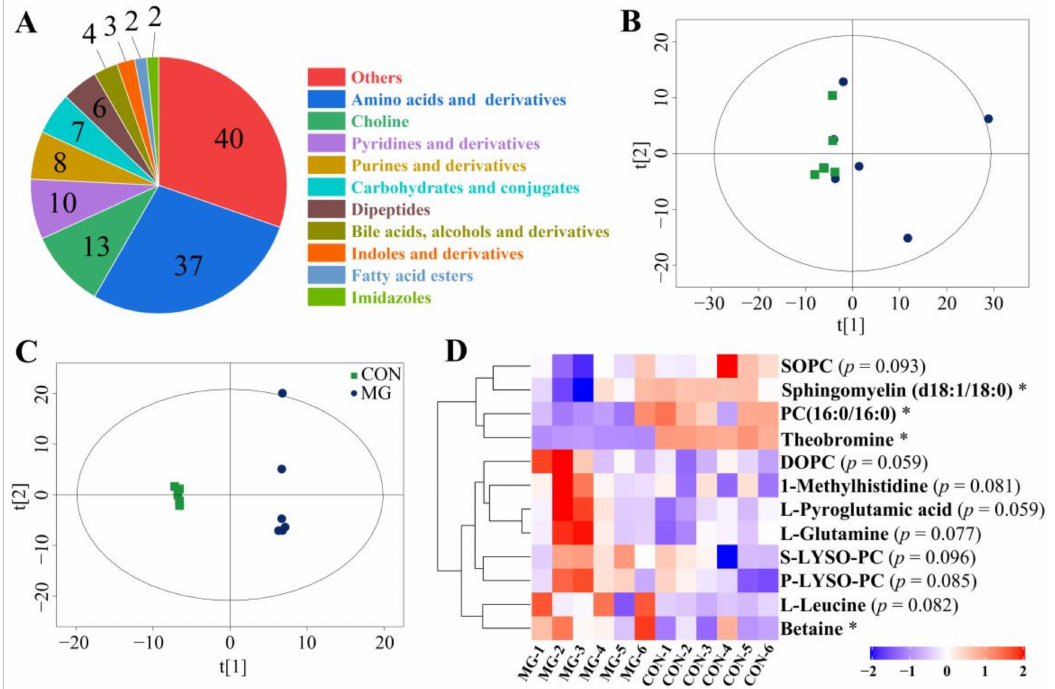
Figure 1. Serum metabolite differences with MG supplementation. ( A ) Pie chart of serum metabolites. Principal component analysis (PCA) score plot ( B ) and OPLS-DA score plot ( C ). ( D ) Heatmap of significant differential metabolites (VIP value > 1, p -value < 0.1). SOPC, 1-Stearoyl-2-oleoyl-sn- glycerol 3-phosphocholine; PC (16:0/16:0), phosphatidylcholine (16:0/16:0); DOPC, 1,2-dioleoyl- sn-glycero-3-phosphatidylcholine; S-LYSO-PC, 1-Stearoyl-2-hydroxy-sn-glycero-3-phosphocholine; P-LYSO-PC, 1-Palmitoyl-sn-glycero-3-phosphocholine. Chicks fed a basal diet (the control group, CON) or a basal diet enriched with 300 mg/kg MG (MG). Data are shown as mean ± SD ( n = 6, * p <